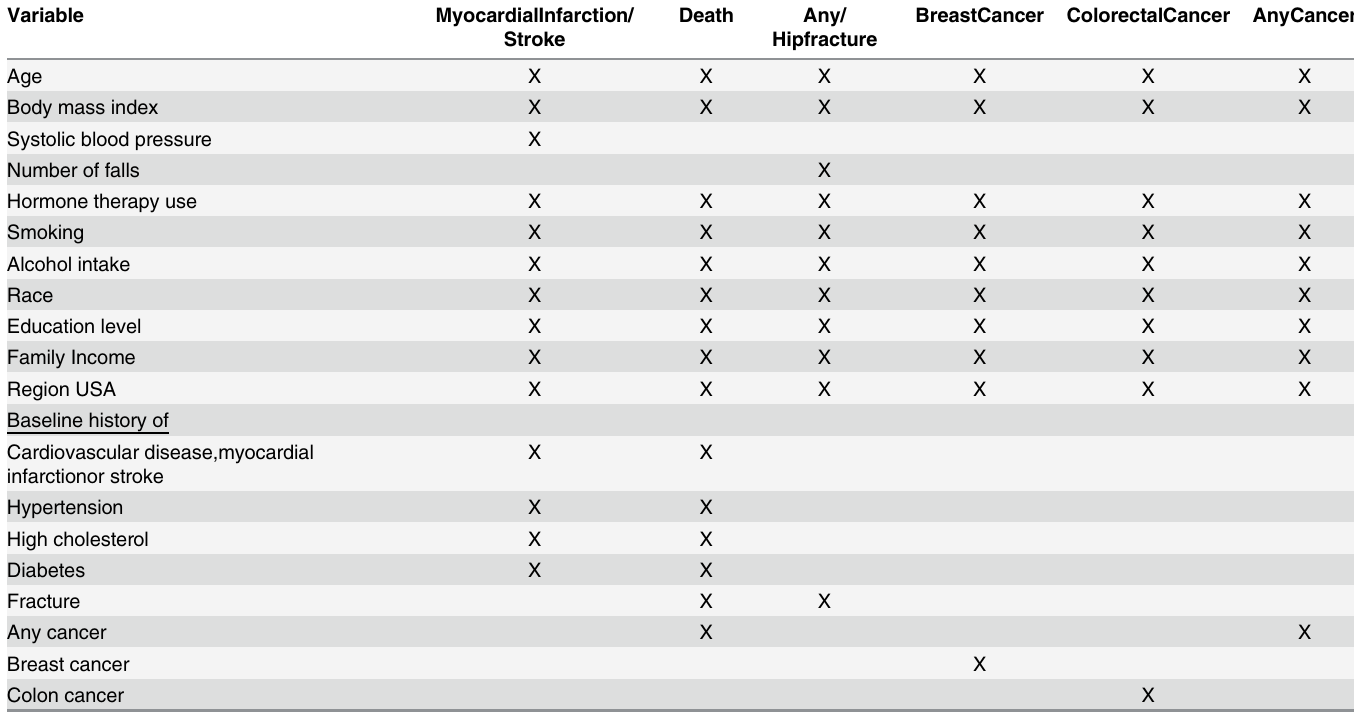
Table 5. Variables included in multivariate